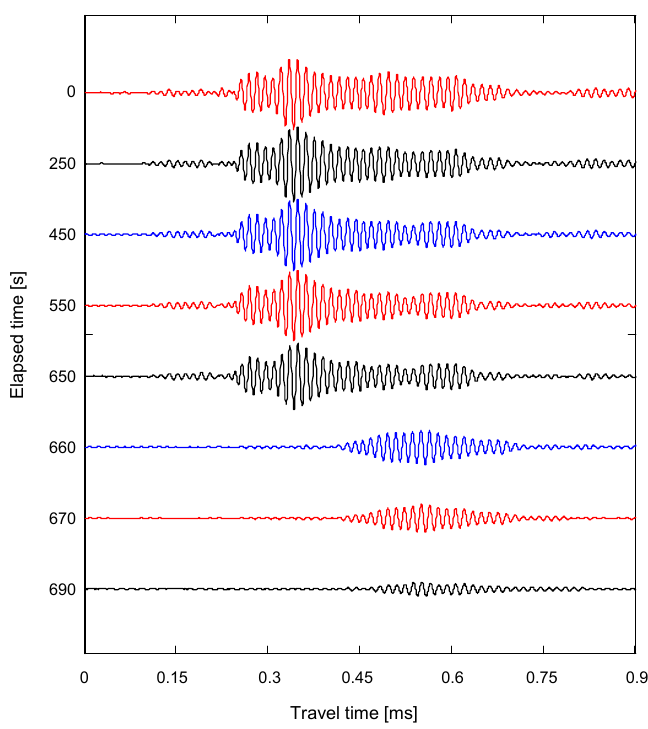
Figure 8. Typical signals obtained in a rock specimen from the wave transducers with the time elapsed. The evolution of the shear wave velocity evaluated from the travel distance of the elastic wave and the first arrival time along the elapsed time is plotted in Figure 9a. Before heating, the values of the shear wave velocities for the hole-to-face distances of 12.5, 18.5, and 25 cm were 2294, 1992, and 1945 m/s, respectively, which were slightly less than the values obtained from the rock core samples.